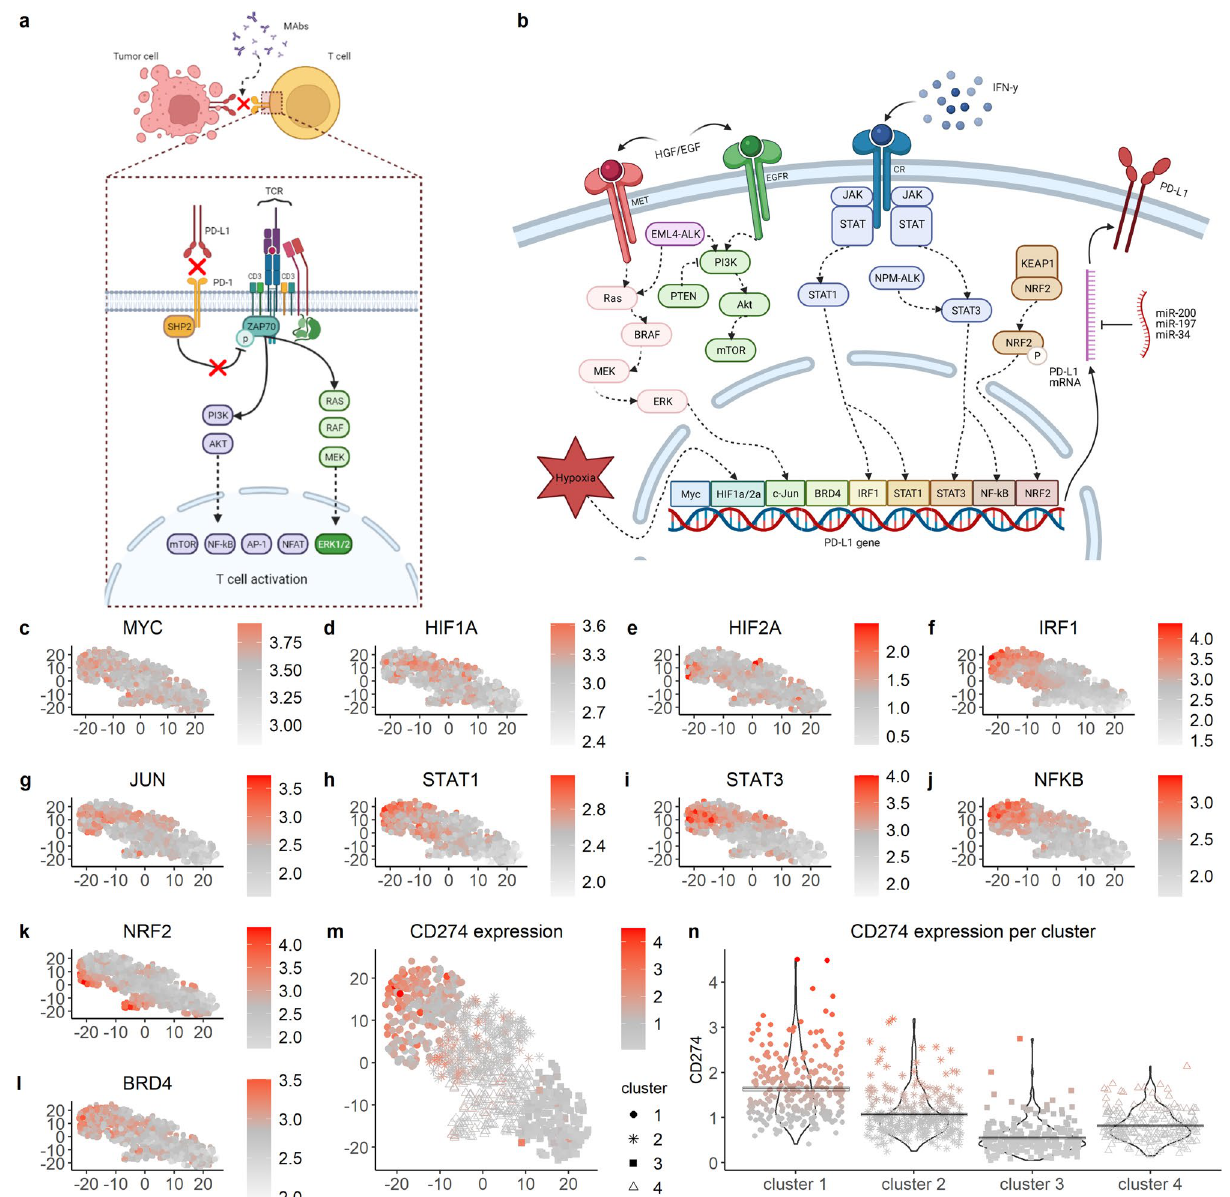
Figure 1. Relationship between transcription factor activity and CD274 expression. ( a , b ) Schematic representations of binding and consequences (red crosses) of PD-1/PD-L1 inhibition ( a ) and of transcriptional and post-transcriptional regulation of PD-L1 ( b ). Both schemes created with BioRender.com. ( c–l ) t-SNE plots based on TCGA data from 960 BRCA patients, taking the activity of the indicated transcription factor estimated by target gene expression as a basis to develop the t-SNE. Color indicates transcription factor activity. ( m ) CD274 expression in the t-SNE plot (note that the t-SNE was developed on the basis of TF activity and not on CD274 expression). ( n ) CD274 expression per k-means cluster (clusters based on the t-SNE plot in ( m sion of the selected target genes correlated reasonably well with the mRNA abundance for a subset of TFs. For example, for IRF1 this is expected because IRF1 transcription and translation both increase in response to IFN-γ signaling 35 (Supplementary file 1, Fig. S1). For other TFs such as NRF2 the correlation was much less clear, likely because NRF2 activity depends on translocation of NRF2 protein to the nucleus rather than on its own transcript levels. In some cases (e.g., STAT3, NFKB)), the correlation between TF activity as estimated from target gene expression and CD274 expression improved substantially compared to using the mRNA expression of the TF directly (Supplementary file 1, Fig. S2), suggesting that our approach to estimate TF activity is valid. In most other cases the resulting correlations from the two approaches remained similar (e.g., IRF1). Subsequently, we used an unsupervised t-SNE analysis to investigate potential patterns in the activity of TFs (as estimated by target gene expression) known to target PD-L1. Although there were no clear t-SNE clusters, some of the TFs, including IRF1, STAT1, and NFKB, exhibited an increased expression in the upper left corner